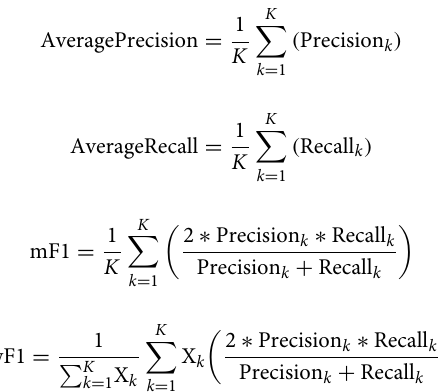
Table 3 summarizes the binary classification results from the three SATs and iDetect. Twelve benign code snippets were incorrectly classified as vulnerable code by iDetect. Evaluation metrics. A confusion matrix 30 is used to evaluate iDetect performance. For binary classifica- tion, we used the F1-Score (F1), where the number of vulnerable codes that are correctly detected is referred to as the True Positive (TP). The number of clean codes detected as vulnerable is called the False Positive (FP). True Negative (TN) codes are correctly detected as clean. False Negative (FN) codes are falsely detected as clean. As a result, the False Positive Rate (FPR) = FP/(TN + FP), the False Negative Rate (FNR) = FN/(FN + TP), the Accu- racy (Acc) = (TP + TN)/(TP + TN + FP + FN), the Precision (P) = TP/(TP + FP), the Recall (R) = TP/(TP + FN), and the F1 = 2 * [(P*R)/(P + R)]. For multiclass classification, we used the macro F1 score (mF1) and weighted-average F1 score (wF1), where K is the number of different types of code snippets (CWE types and Benign) = 30 types, and N is the number of samples = 322 samples.